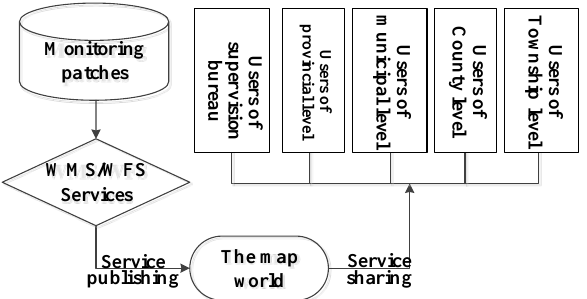
Figure 4 The monitoring data publishing based on the Map